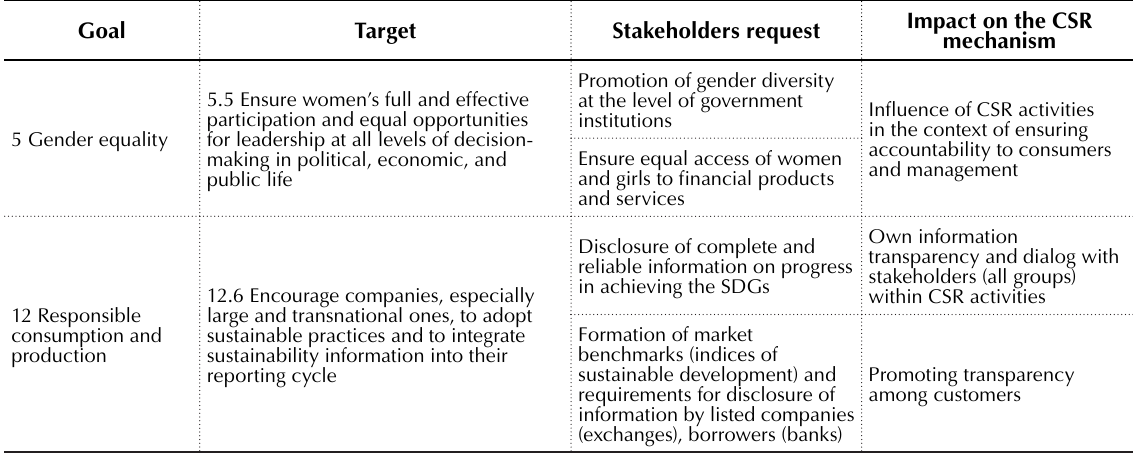
Table 2. The most relevant SDGs, which are inherent in the internal activities of such institutions and their impact on the CSR